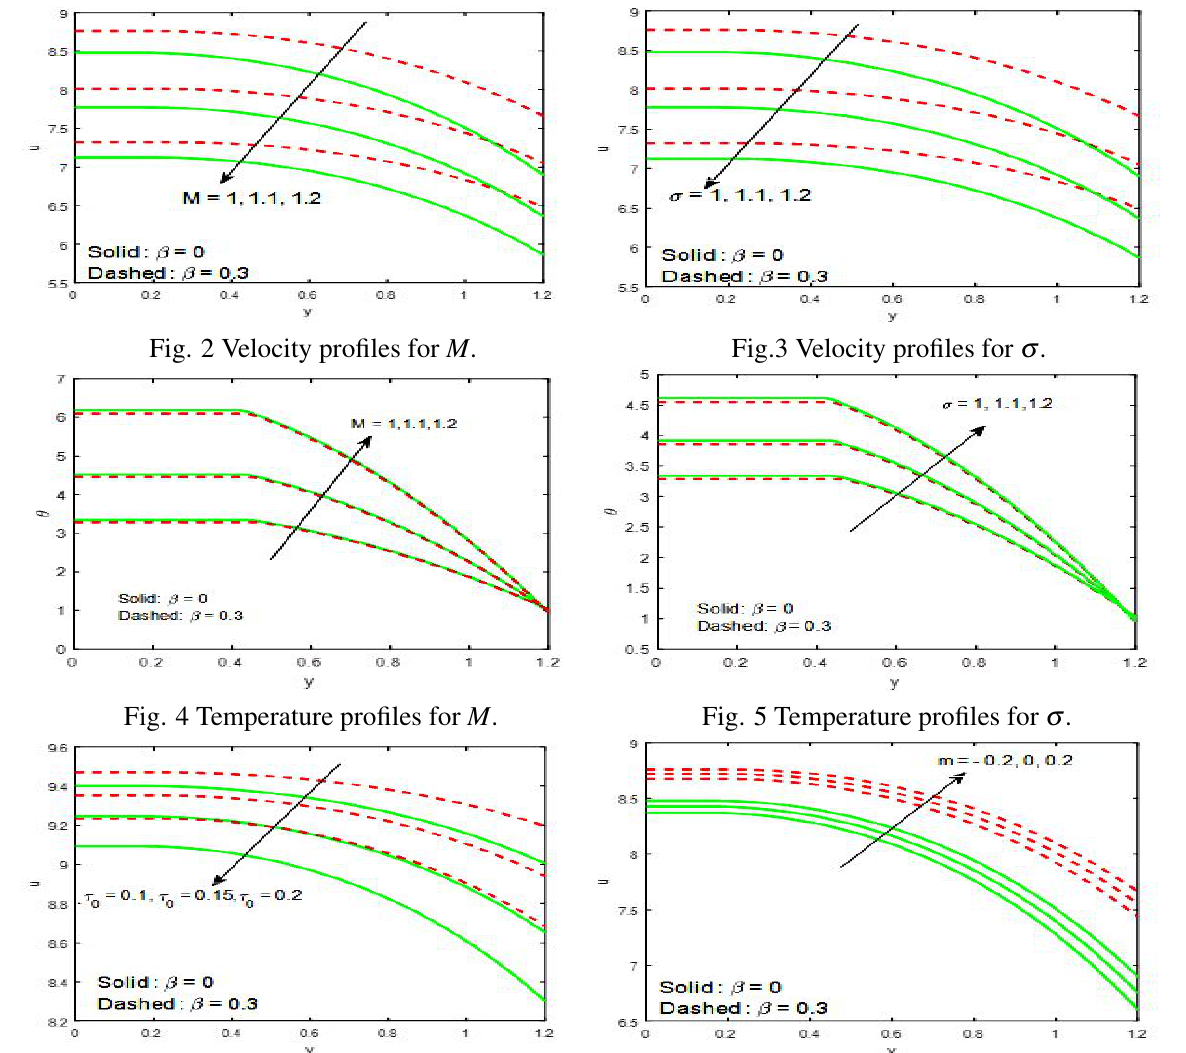
Fig. 6 Velocity profiles for τ 0 . Fig. 7 Velocity profiles for m